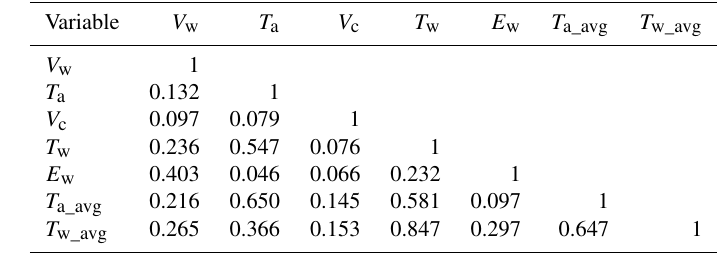
Table 3. Pearson product-moment correlation coefficients of the metocean variables in the developed fracture model. The variables included water temperature ( T w ), wind speed ( V w ), air temperature ( T a ) , current speed ( V c ), wave energy index ( E w ) , lifetime mean air temperature ( T a_avg ), and lifetime mean water temperature ( T w_avg )